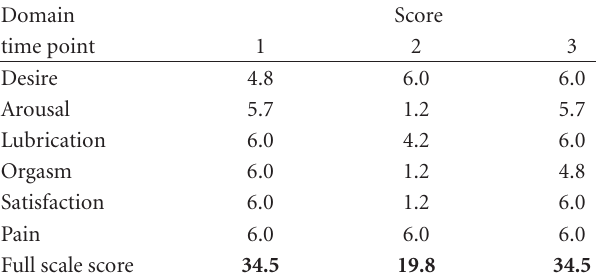
Table 3: UAE patient